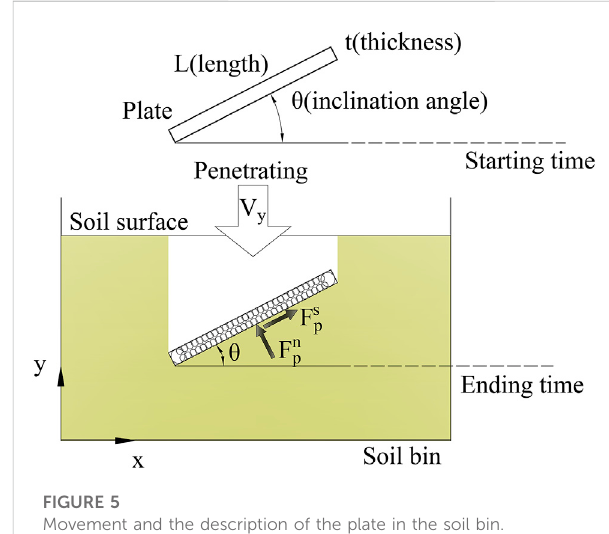
FIGURE 5 Movement and the description of the plate in the soil bin.